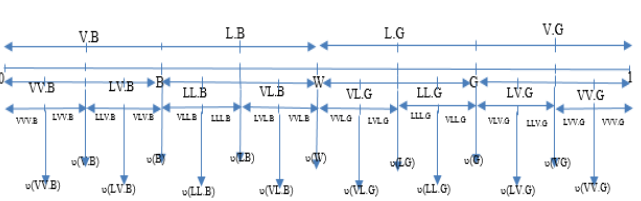
Figure 1. Similar space partition segment [0,1] by hedge algebra